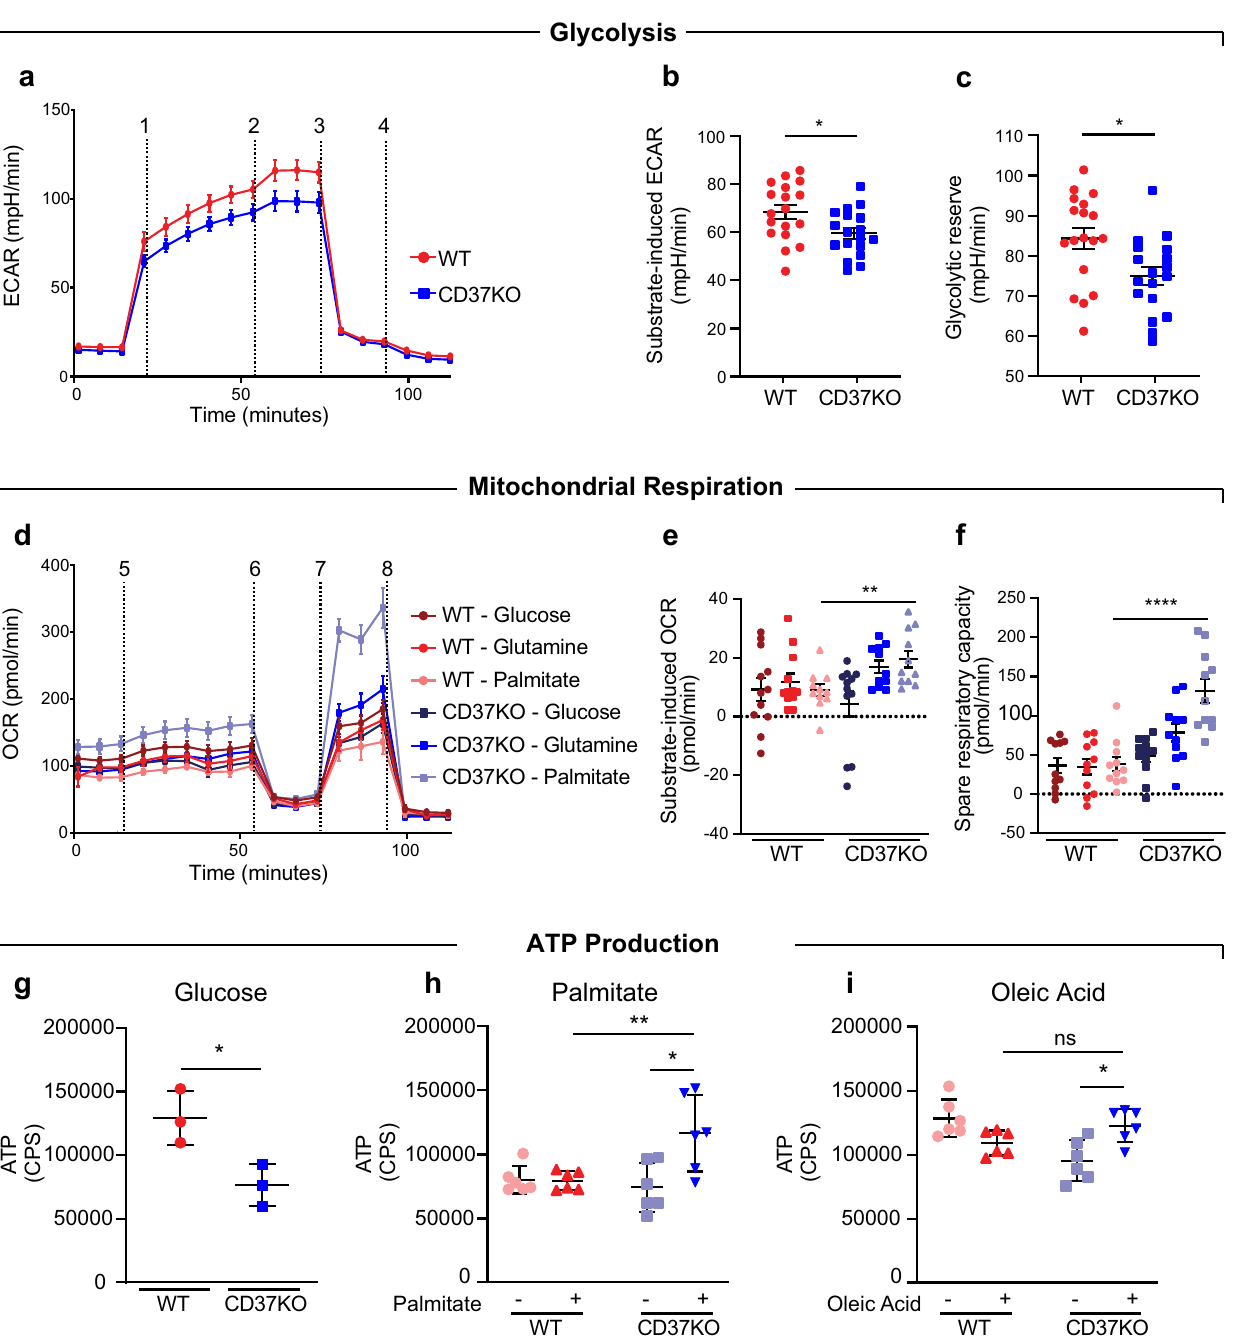
Fig. 1 | Different metabolic preferences of WT and CD37KO human B-cell lym- phomas. Seahorse analysis of glycolysis ( a – c ) and mitochondrial respiration ( d – f ) in B-cell lymphoma. Cells (WT and CD37KO BJAB) were incubated in nutrient- restricted ( a ) or nutrient-rich ( d ) medium for 2h and subjected to an acute sub- strate injection (1in a , 5 in d ) of glucose (10mM), glutamine (10mM), or palmitate (50 µ M). Continuous extracellular acidi fi cation (ECAR) ( a ) or oxygen consumption ratio (OCR) ( d ) values are shown in response to 2, 6: Oligomycin A (1 µ M), 3: 2-DG (20mM),7:FCCP (1 µ M)and 4,8:Rotenone/AntimycinA (Rot/AA) (1 µ M).Substrate- inducedECAR( n= 18, p= 0.0191)( b )orOCR( n= 12, p= 0.0032)( e )werecalculated as the difference between baseline and acute substrate injection (1, 5). Glycolytic reserve ( c ) was calculated as the difference in ECAR between baseline and